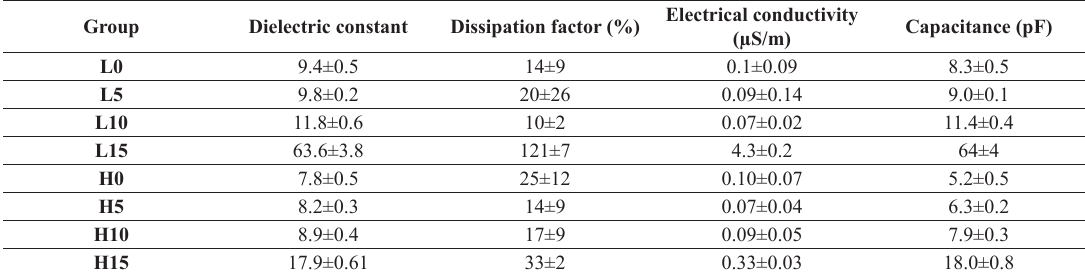
Table 4. Electrical properties measured at 1.0 kHz.